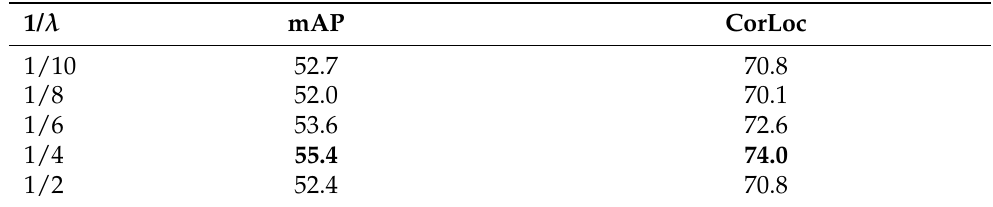
Table 5. The effect of the removal coefficient 1/ λ